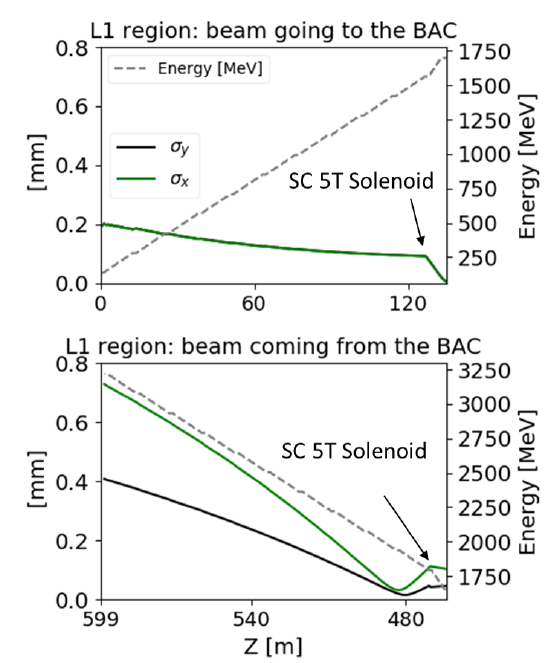
Figure 2. The upper plot shows beam envelopes and energy gain in the L1 region. The lower plot exhibits same parameters for the way back beam during the L1 region second passage. The RF ponderomotive and solenoid focusing effects, unchanged for the two different directions, perfectly control the beam envelopes in both directions.